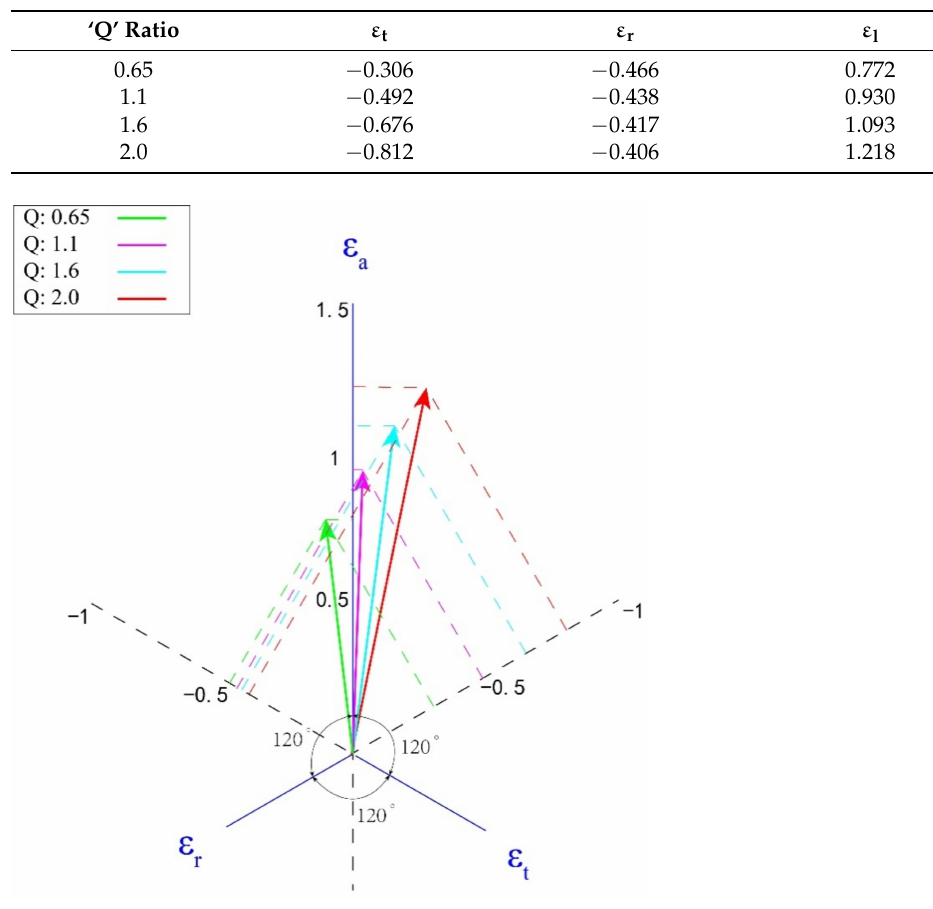
Figure 6. Strain vector in plane triaxial strain